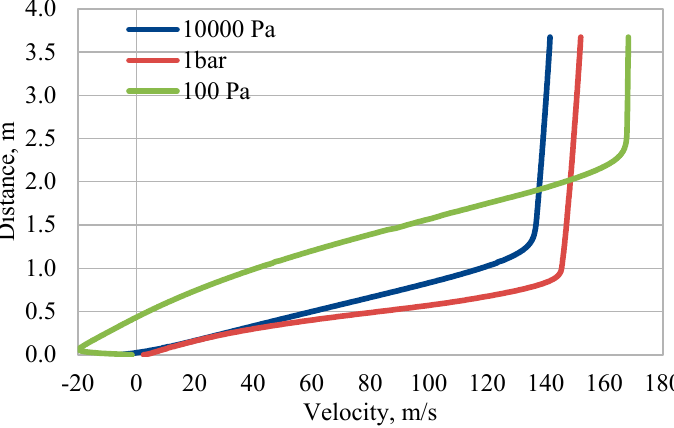
Figure 9. The velocity profile at 29 m of the vehicle length for 100 Pa, 10 kPa, and 1 bar. There is no separation for 1 bar pressure in the tunnel at this location.